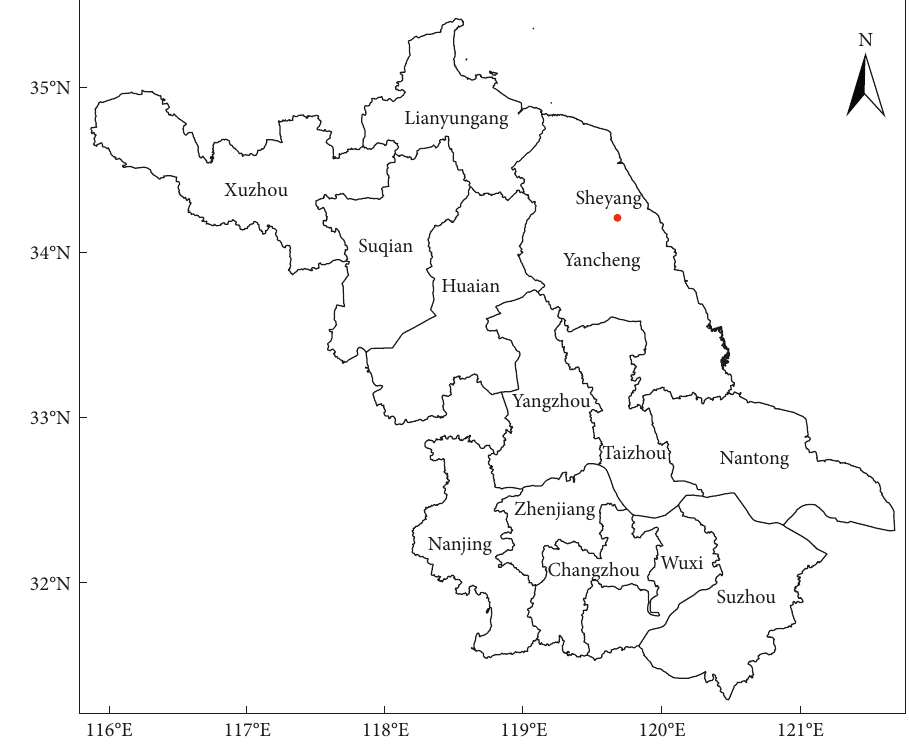
Figure 1: Map showing the location of the Sheyang site in Jiangsu